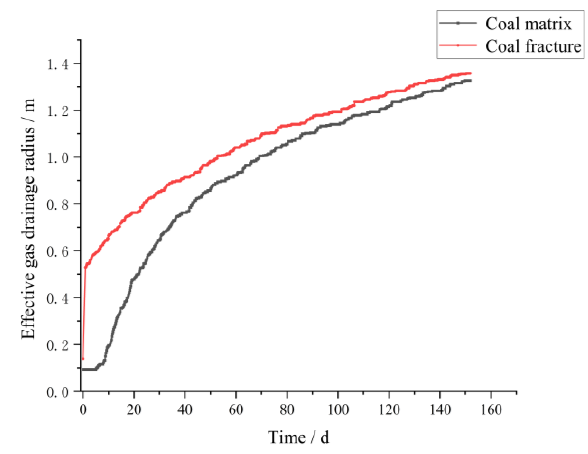
Figure 2. Change in effective extraction radius under different extraction time.